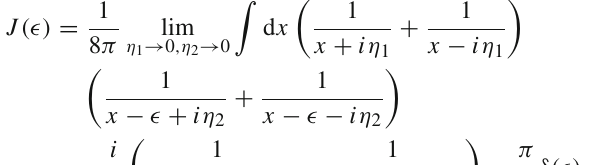
Fig. 8 Cut amplitudes with vertices (cid:2) R → RRG and (cid:2) R → RRRG after reduction in Fig. 2